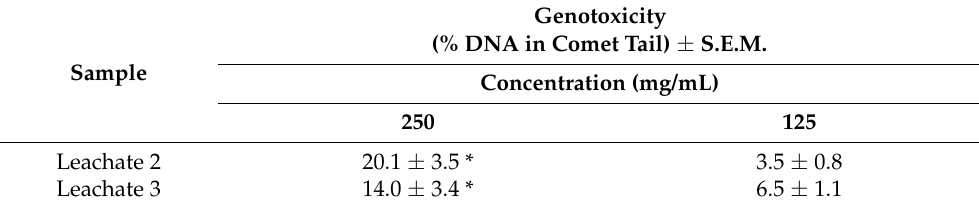
Table 4. Genotoxicity of the leachate sampled from the landfill to A-549 lung epithelial cells as % of DNA in the comet tail in the alkaline comet assay. Results presented as the mean of the 50 cells analysed for each concentration ± S.E.M. * Results significantly different from unexposed control ( p <